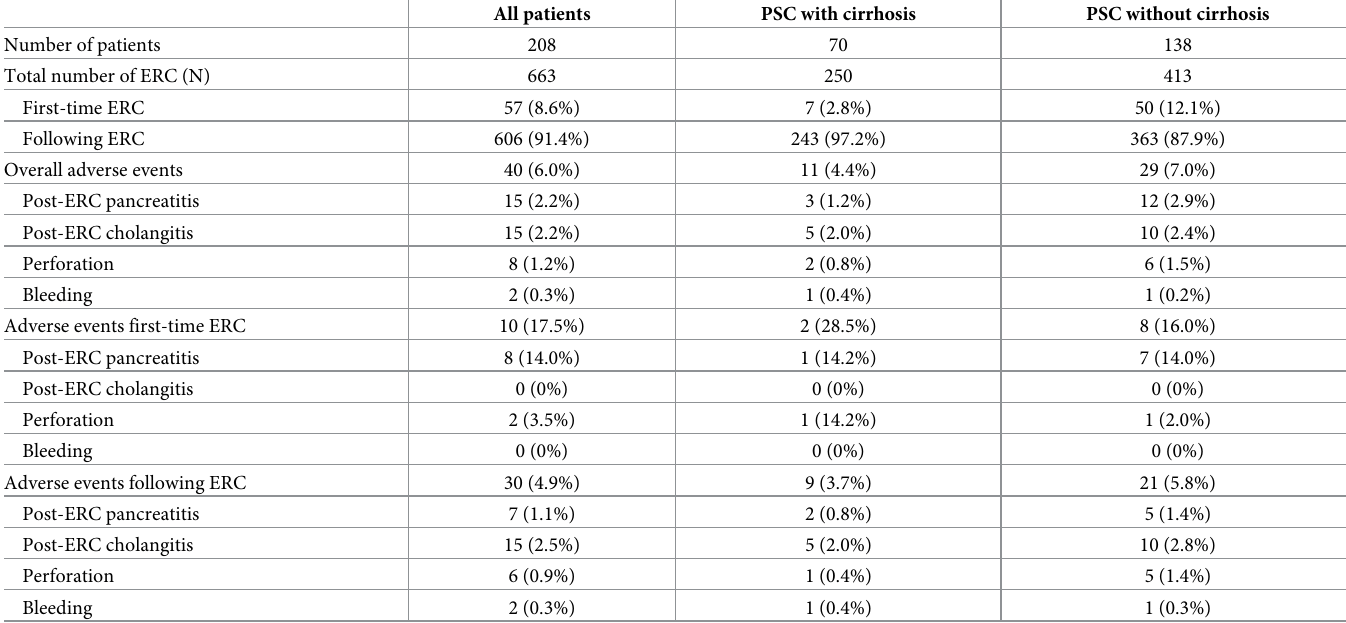
Table 3. Adverse events in patients with and without